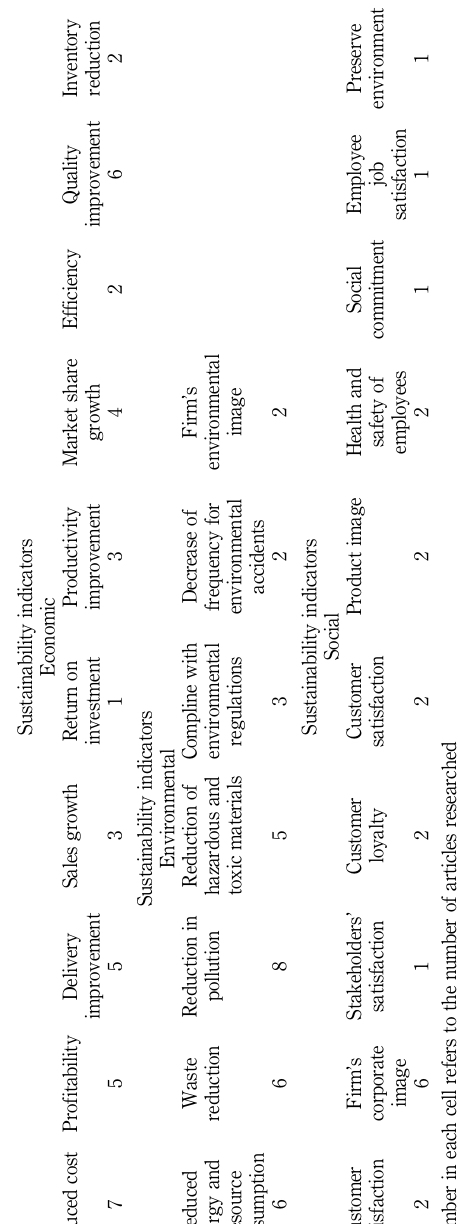
Table IV. A holistic picture of RL and its respective impact on each dimension of the sustainability performance in the perspective of GSCM through relevant